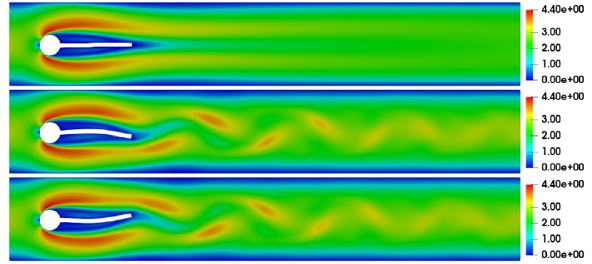
Table 1 Results for the quantities of interest for the mean and the amplitude on three different mesh levels with 19248, 75712 and 300288 degrees of freedom with two different time step sizes Δ t for the Newtonian FSI3 benchmark